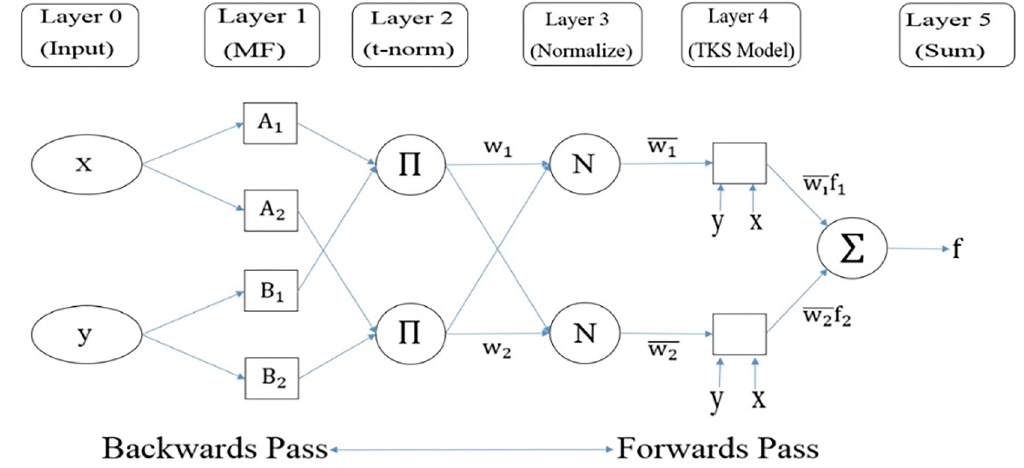
Figure 2. The primary architecture of the ANFIS [24].